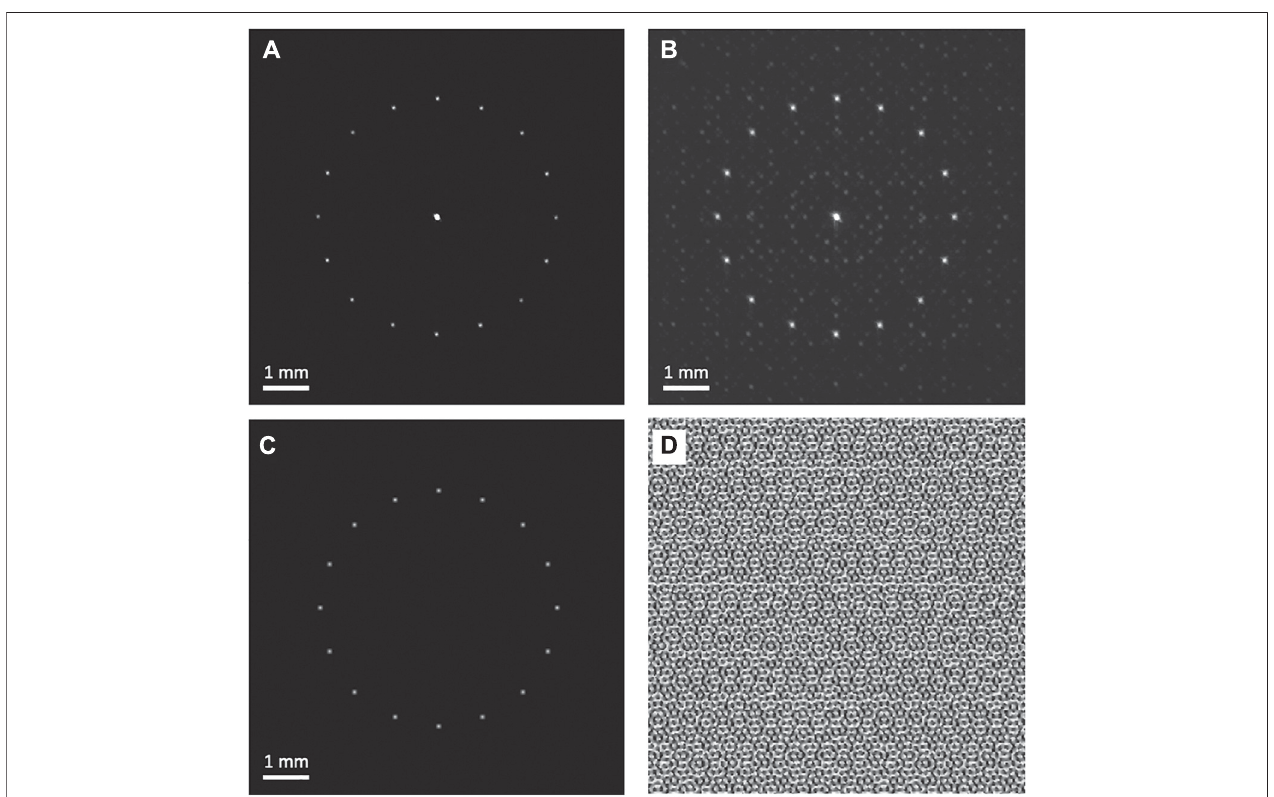
FIGURE 1 | The Unmodulated Light focuses to a central bright spot and ghost patterns are formed due to diffraction from the SLM. (A) Intensity pattern from the conventionalbeampathcapturedbyansCMOScamerathatis,positionedintheobjectplane.Theunmodulatedlightisfocusedatthecenterofthe fi eldofview(FOV)by the objective lens creating an undesired central focal point. (B) intensity-adjusted representation of A highlighting ghost patterns. (C, D) Target intensity pattern and its corresponding phase mask.